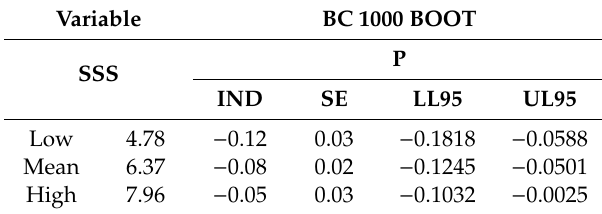
Table 5. Indirect e ff ect of subjective social status (SSS) on presenteeism, by level of SSS. Variable BC 1000 BOOT P SSS IND SE LL95 UL95 Low